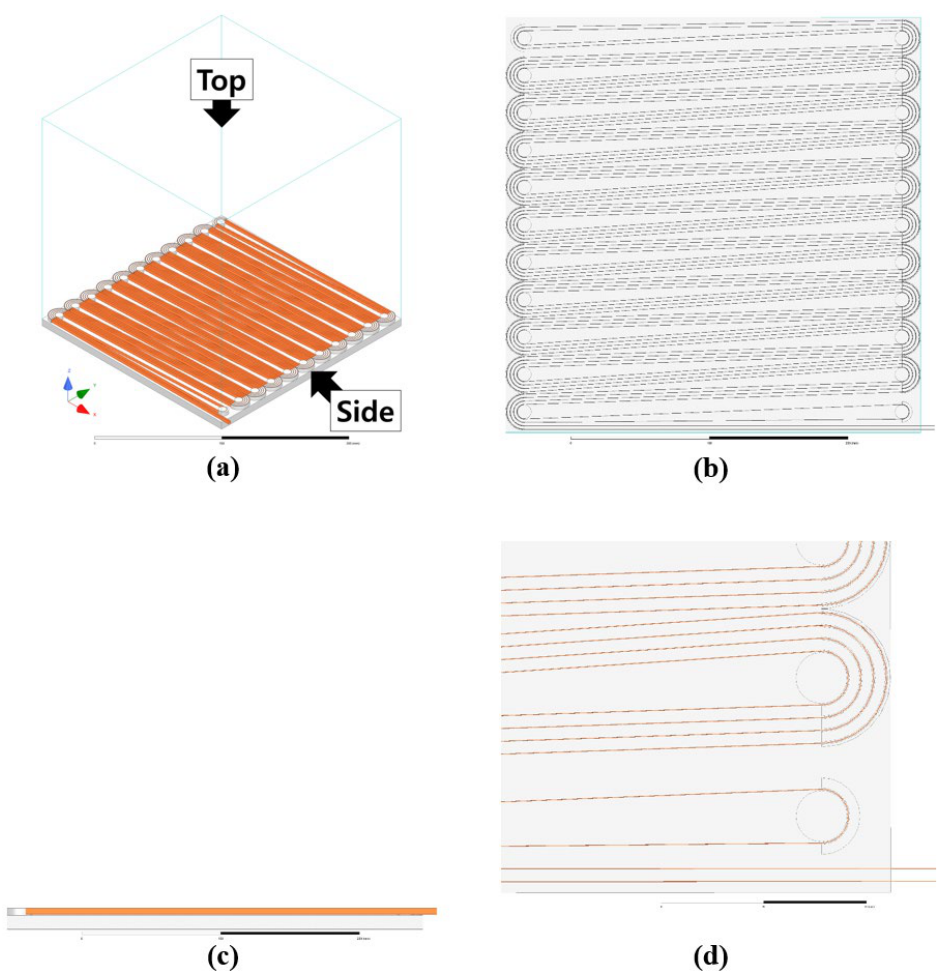
Figure 10. Superconducting module modeling with the bifilar-meander type: ( a ) overall, ( b ) top view, ( c ) side view, ( d ) bifilar view.